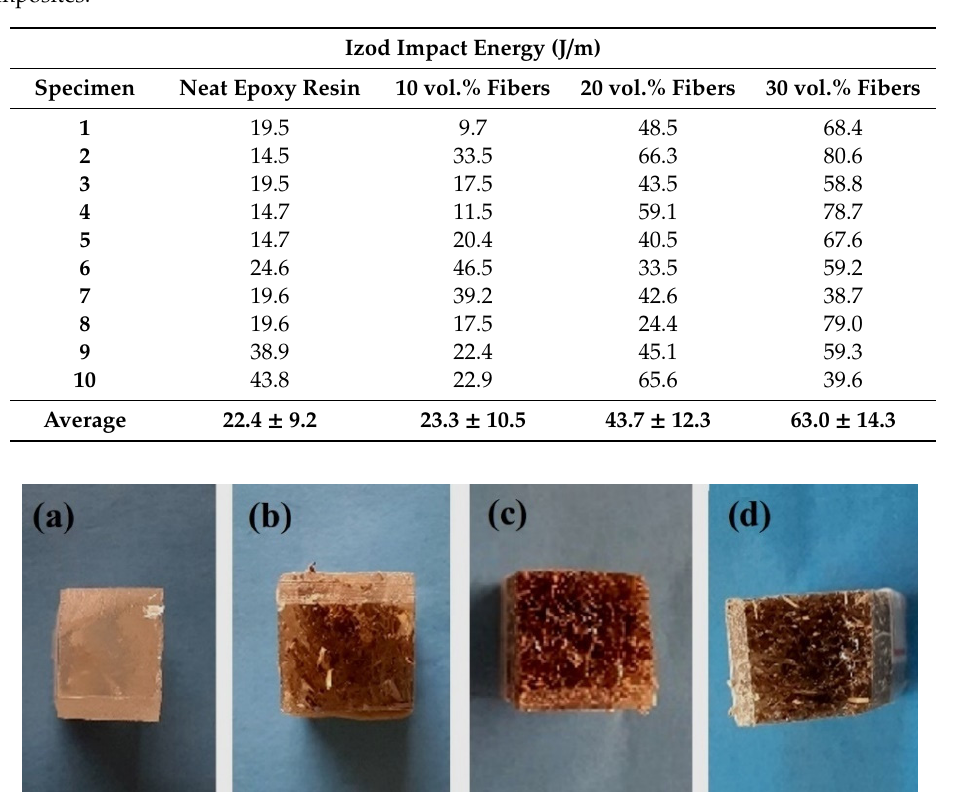
Figure 3. Fractured specimens after Izod impact test: ( a ) neat epoxy resin; ( b ) 10 vol.% of CM fibers; ( c ) 20 vol.% of CM fibers; ( d ) 30 vol.% of CM fibers.